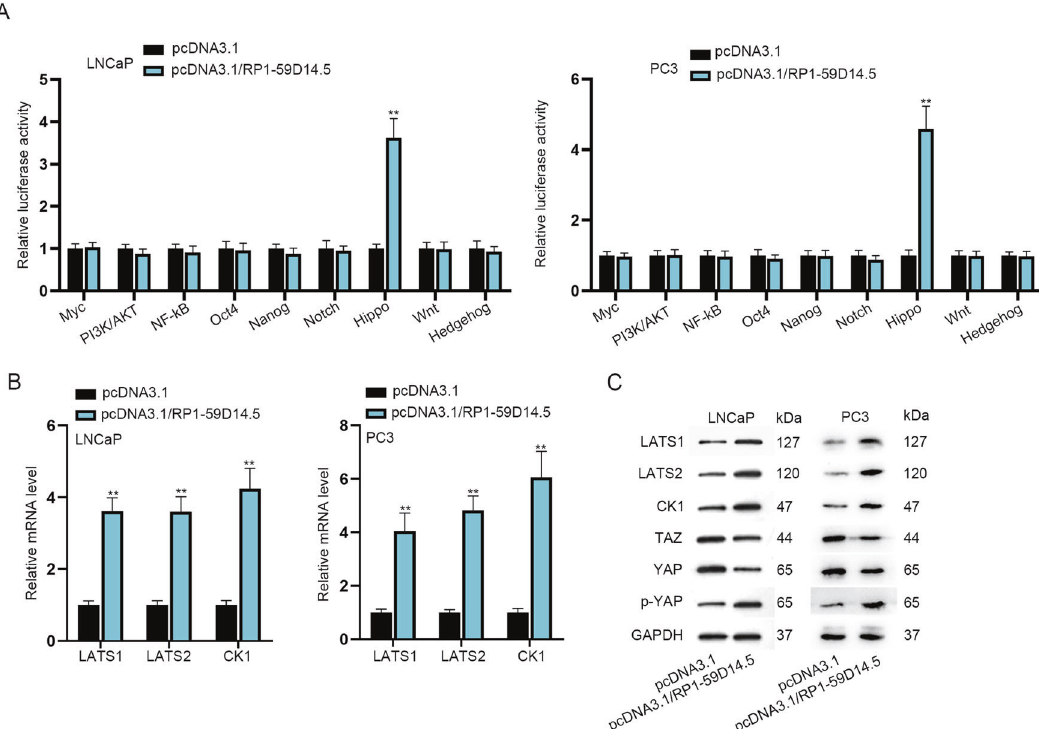
Fig. 2 RP1-59D14.5 activates the Hippo pathway in PCa cells. A The activities of various pathways were detected by luciferase reporter assays. B , C RT-qPCR was used to detect mRNA levels of LATS1/2, CK1, and western blot analyzing protein levels of LATS1/2, CK1, TAZ, YAP,